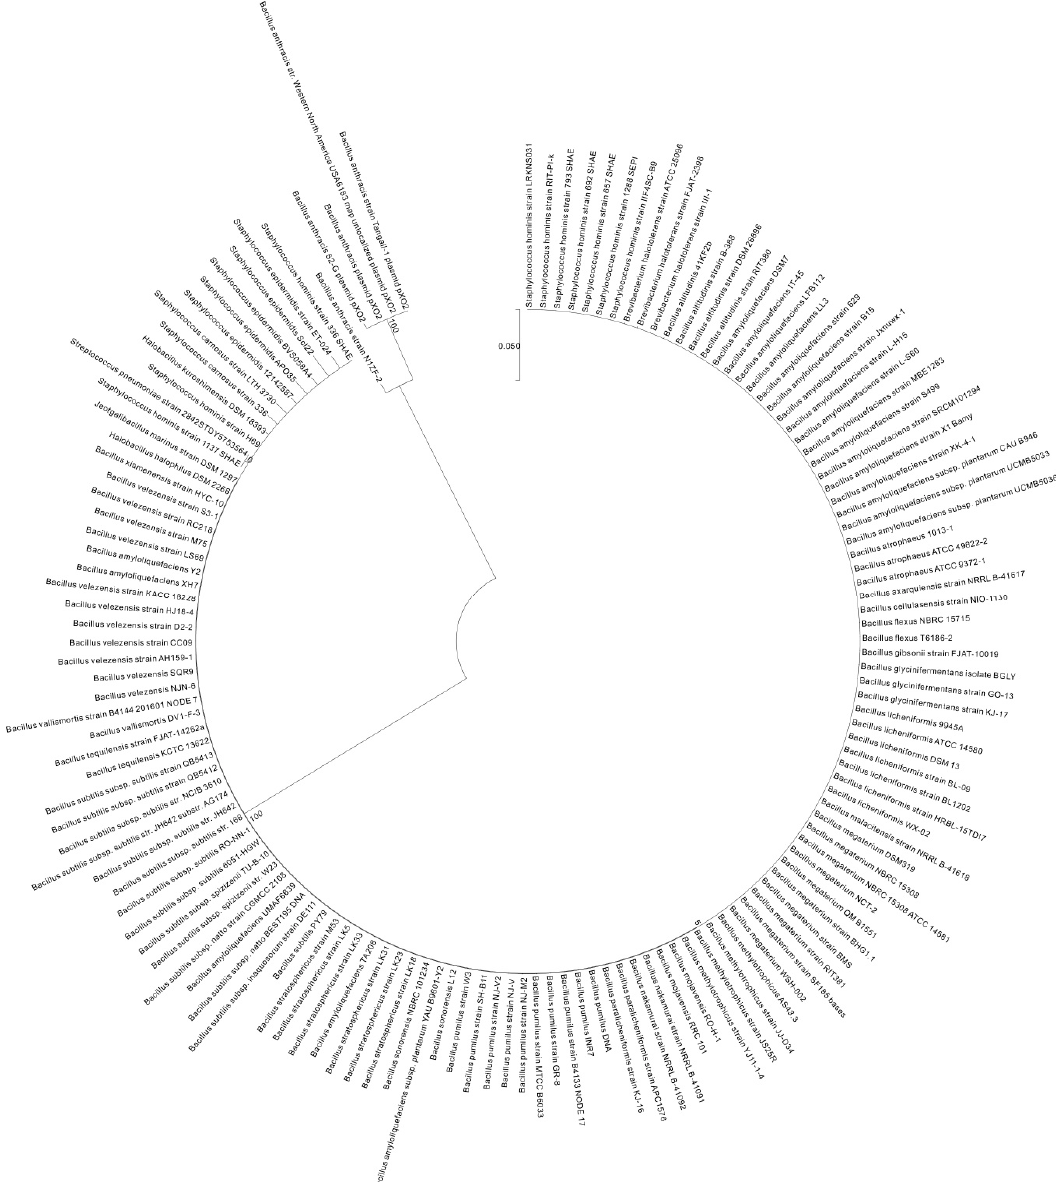
Figure 4. Molecular phylogenetic analysis of pgsC by the maximum likelihood method. The phylogenetic tree with branch lengths was measured as the number of substitutions per site. The analysis involved 192 nucleotide sequences. Partial deletion was used and all positions with less than 95% site coverage were eliminated, i.e., less than 5% of the alignment gaps, instances of missing data, and ambiguous bases were allowed at any position. Scale bar: number of substitutions per site. Evolutionary analyses were conducted in MEGA7 [38].